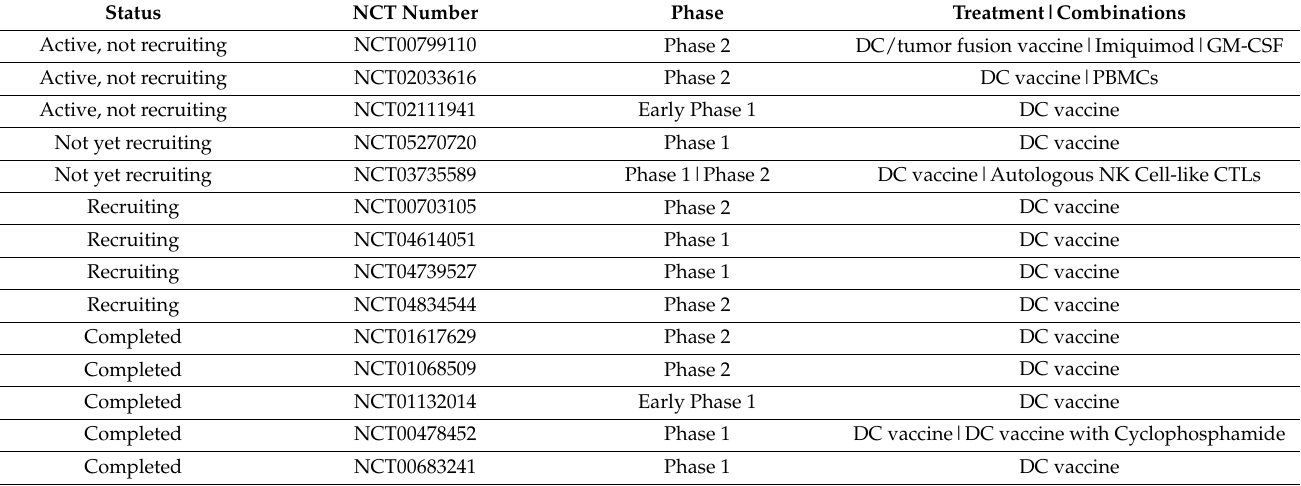
Table 1. Overview of the clinical trials on DC vaccination against OC registered on ClinicalTrials.gov (accessed on 15 August